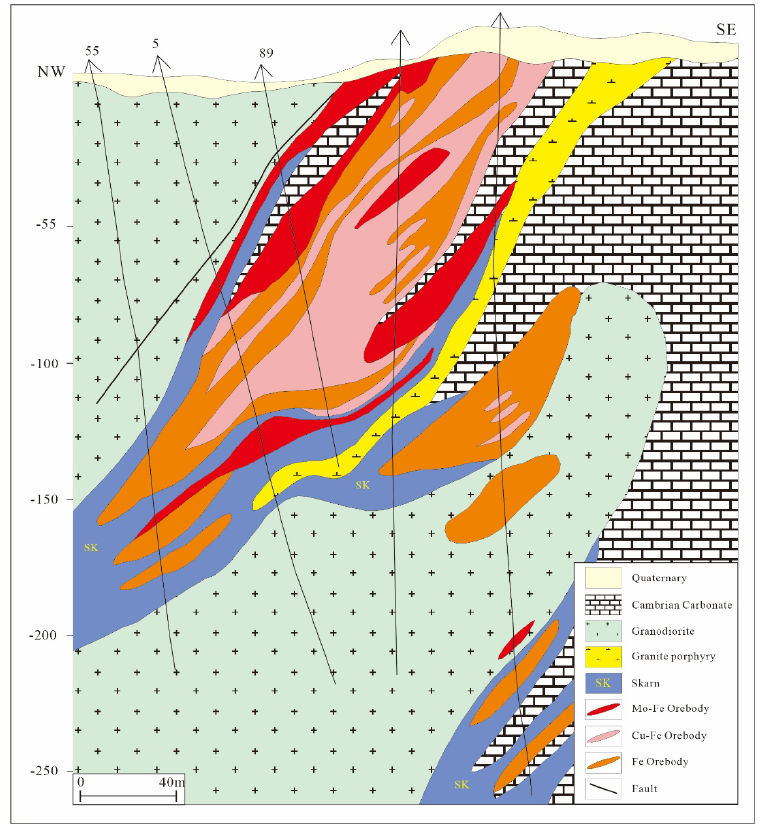
Figure 3. The geological cross-section of the exploration line of the Xianlin Mo(Cu)-Fe deposit